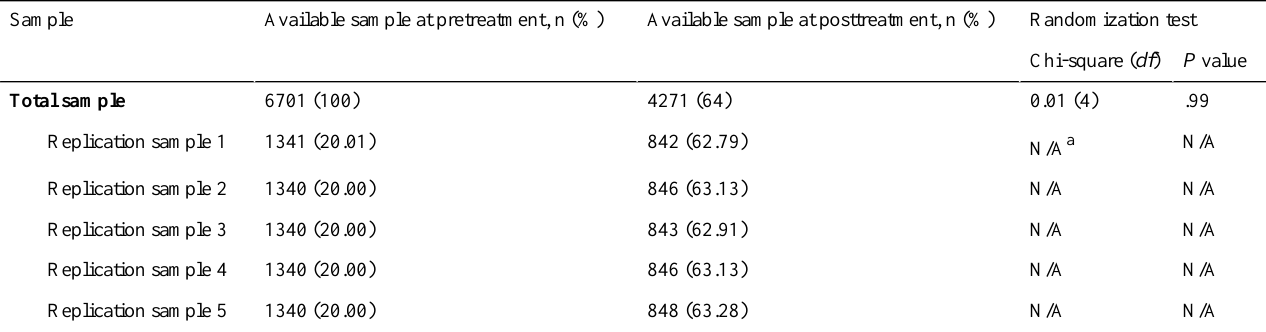
Table 1. Randomization of cross-validation samples and participant characteristics (N=6701).